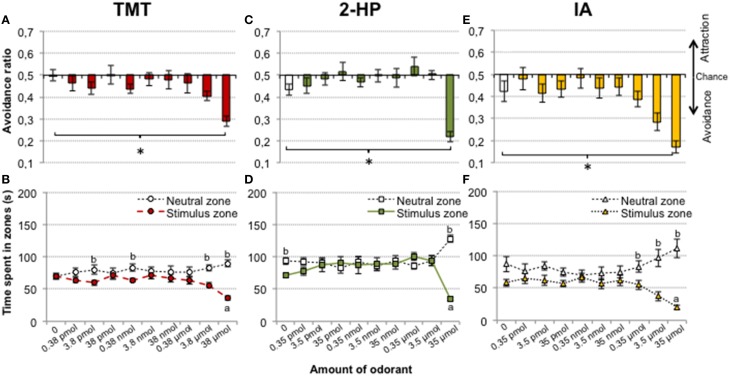
TMT, 2-HP, and IA induced avoidance in a concentration-dependent way. Bar and line charts representing the avoidance ratio and time spent in each zone for increasing concentrations of each odorant. For all three odorants, the avoidance ratio was significantly different from the control situation (no odor) only when pure substance was presented (A,C,E, *p < 0.05). Time spent by the animals at the stimulus zone was dose-dependently decreased by TMT with respect to the neutral zone (B), whereas 2-HP did not induce avoidance except when presented pure (D). Finally, IA produced a pattern of avoidance similar to that of TMT (F). Comparison between the stimulus zone with the same zone in the control (no odor): a, p < 0.05. Comparison between the stimulus and the neutral zones: b, p < 0.05. Data are represented as mean ± SEM.